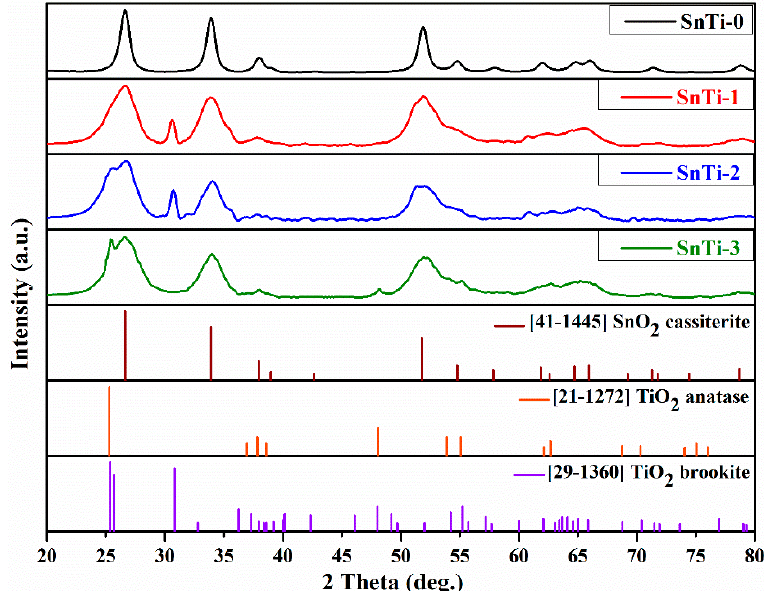
Figure 4. XRD patterns of nanocrystalline SnO 2 and TiO 2 @SnO 2 composites and references for SnO 2 cassiterite (ICDD 41-1445), TiO 2 anatase (ICDD 21-1272) and TiO 2 brookite (ICDD 29-1360).